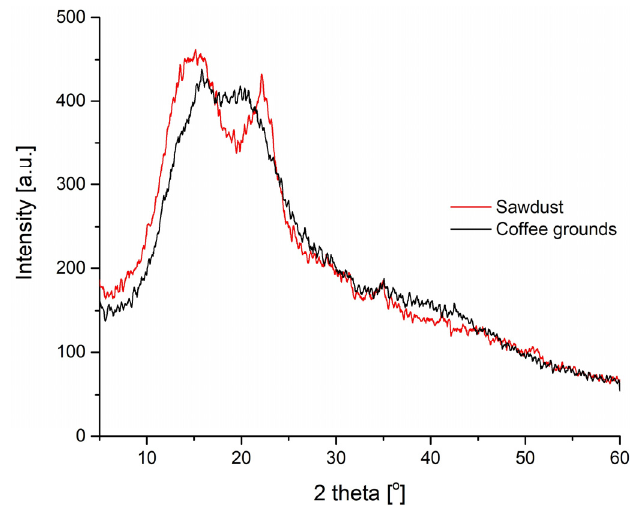
Figure 9. The XRD patterns recorded for sawdust and coffee grounds.